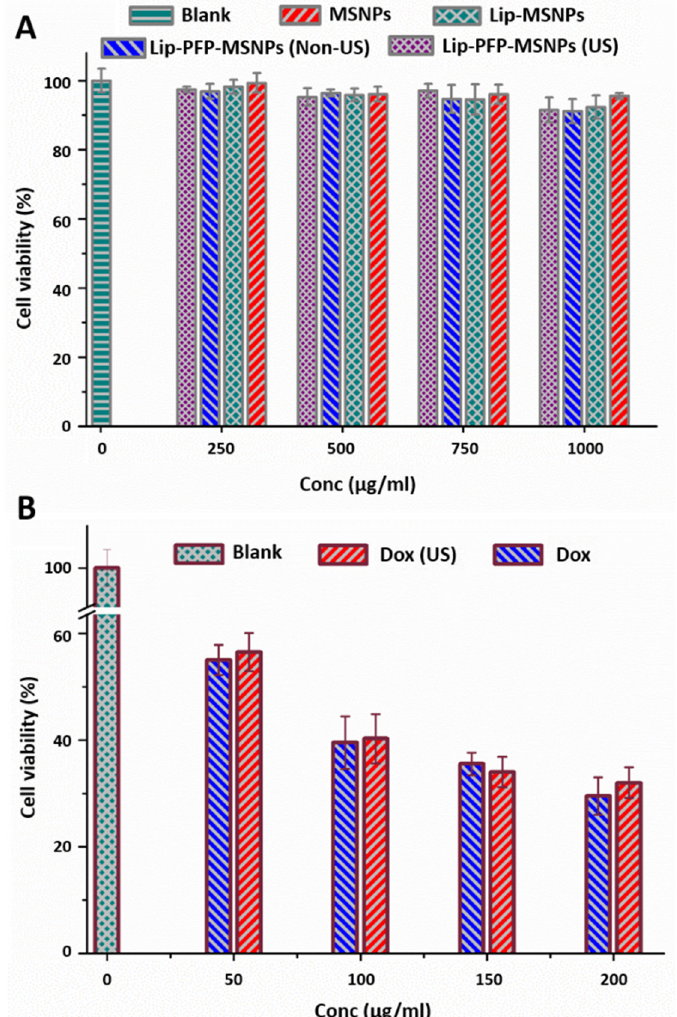
Figure 7. Cytotoxic effects by MTT assay of ( A ) unloaded carriers, including MSNPs, Lip-MSNPs, Lip-PFP-MSNPs (Non-US), and Lip-PFP-MSNPs (US) and ( B ) Dox (Non-US) and Dox (US). US specifications were 5 min, 12 MHz, and MI 1.4, and US-irradiated cells were taken as blank.